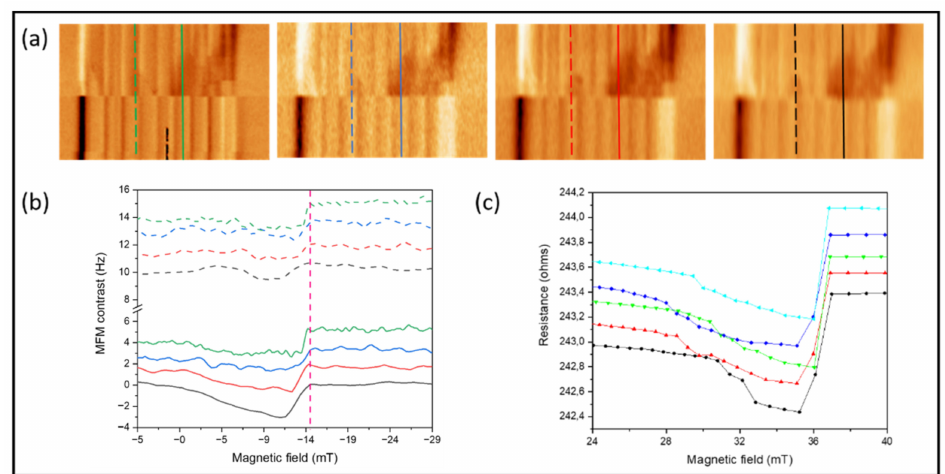
Figure 4. ( a ) A series of 3D MFM images obtained by sweeping the in-plane magnetic field from 8 to − 29 mT. ( b ) Profiles obtained along the dashed lines (upper panel) and solid lines (bottom panel). The average switching field is marked by a dashed pink line. ( c ) Successive magnetoresistance curves measured under the same conditions.